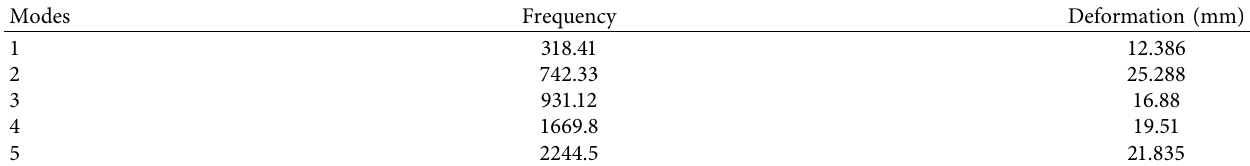
Table 8: Modal analysis results of carbon composite crankshaft.